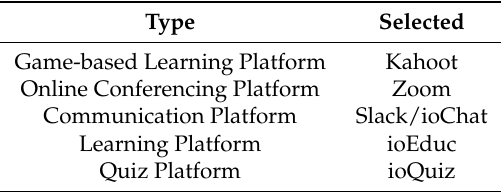
Table 2. Group of tools used in